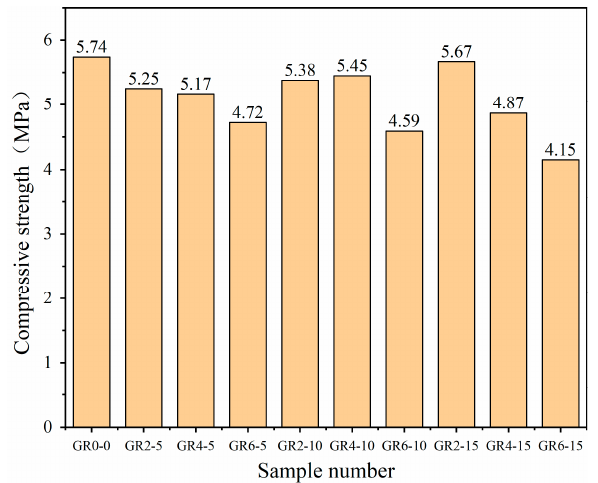
Figure 8. Compressive strength of various types of mortar on the third day.